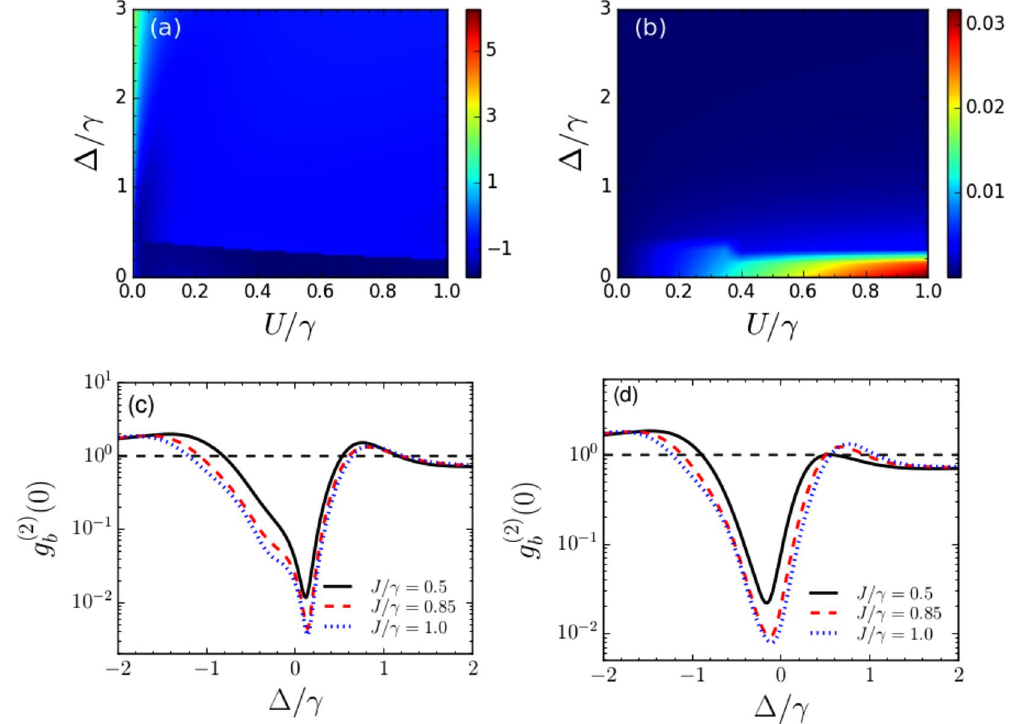
(2) as functions of normalized detuning Δ / κ and U / κ and ( b ) plot of Figure 6. ( a ) Logarithmic plot of g (0) b (2) for different values of J with phonon number in the primary resonator for ζ − , φ − . ( c ) Variation of g (0) b U opt = 0.5 γ and Δ opt = 0.15 γ . The black solid, red dashed and blue dotted lines correspond to J = 0.5 γ , 0.85 γ and γ , and the corresponding values of { ζ − , φ − / π } are {2.25, 0.30}, {1.51, 0.32} and {1.37, 0.33} respectively. ( d ) (2) for U = 0.5 γ and Δ = − 0.15 γ for J = 0.5 γ (black solid line), 0.85 γ (red dashed Shows the variation of g (0) opt opt b line) and γ (blue dotted line). The corresponding values of { ζ − , φ − / π } are {2.23, 0.38}, {1.52, 0.37} and {1.37, (2) 0.36} respectively. The dashed black lines correspond to = g (0) 1 b